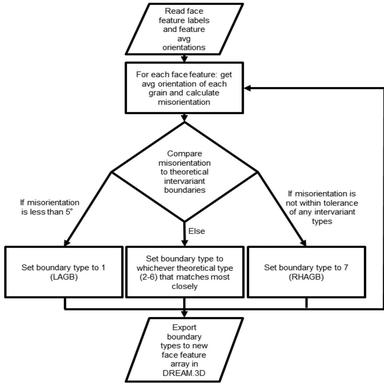
A flowchart representation of the algorithm for classifying boundaries. Inputs include the labels of each face feature and the average orientation of each feature. The algorithm calculates the average misorientation for each face feature and compares with the BOR intervariant boundaries to classify each face feature as a LAGB, intervariant type 2-6, or RHAGB. The output is a face feature level array containing the boundary types which can be imported back into DREAM.3D for visualization or further analysis.